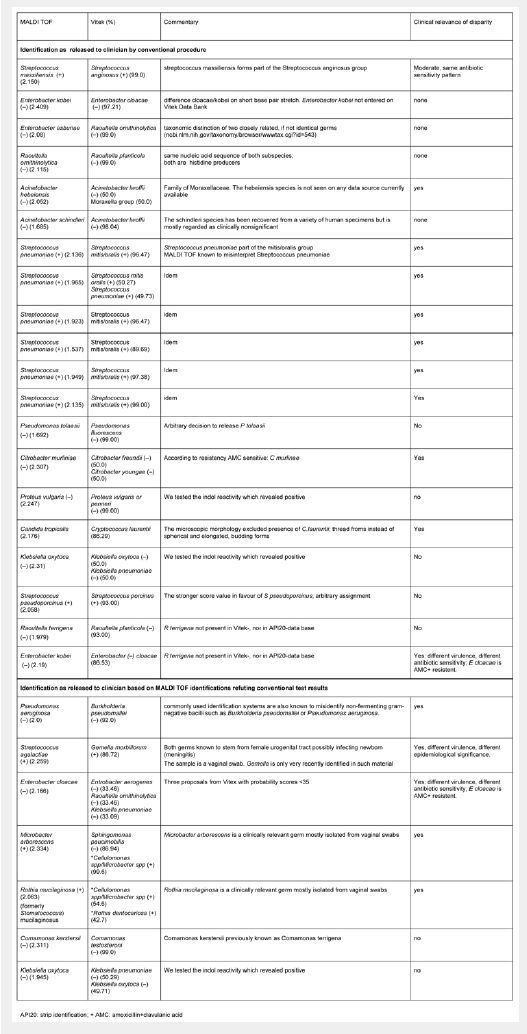
Discordant results etween MALDI and Conventional Identification for 27 clinical